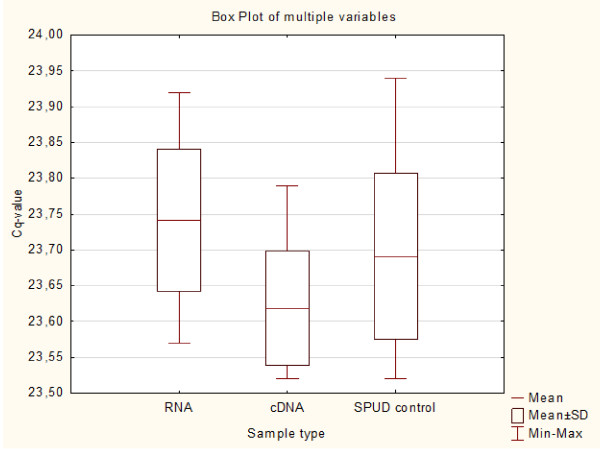
Results of the SPUD assay. Box plot of the Cq values obtained after the analysis of 3 sample types (RNA, cDNA and control) in a SPUD assay. For RNA/cDNA 14 different samples were measured in duplicate, 14 replicates were used for the SPUD control.